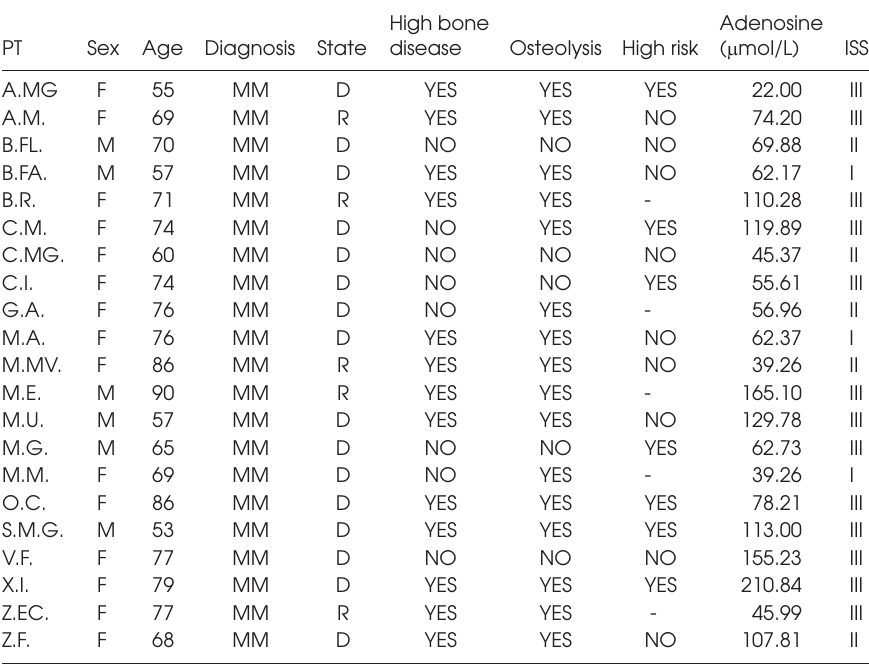
table 1. Main clinical and molecular characteristics of the cohort of 21 patients with symptomatic